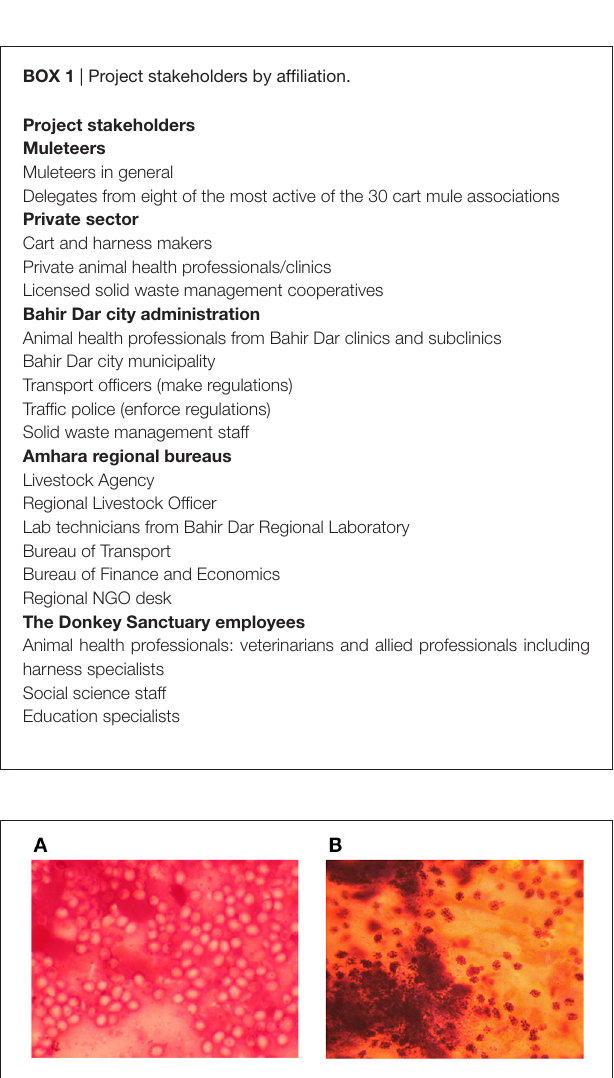
FIGURE 2 | Photomicrographs of Histoplasma capsulatum var. farciminosum yeast cells showing intact nonstaining yeast cells sampled from an early case (A) and disintegrated yeast cells with deep-staining dotted granules from an advanced case (B)